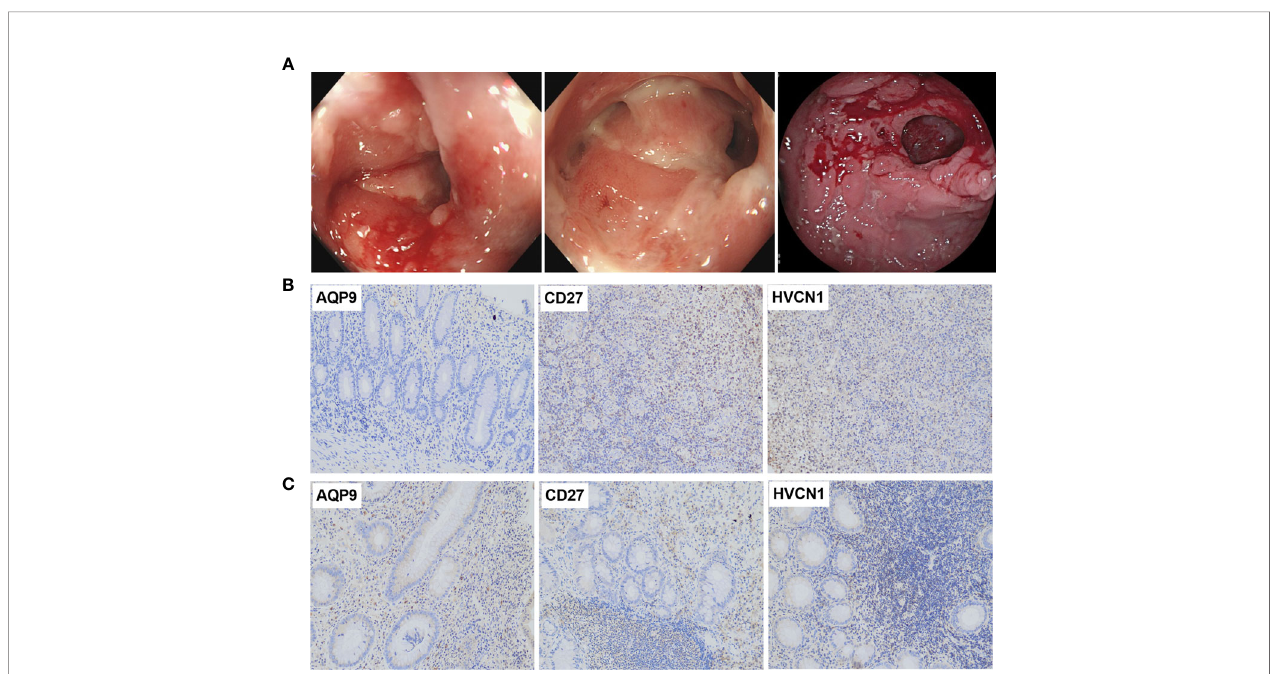
FIGURE 6 | (A) Typical endoscopic images of CD: left, ileum in remission; middle, ileocecal valve; right, colon with ulcer; (B) Expression of AQP9 , CD27 and HVCN1 in adjacent normal intestinal tissues, fewer immunostaining can be seen in the mucosa (Magni fi cation ×200); (C) Expression of AQP9 , CD27 and HVCN1 in CD tissues, more immunostaining can be seen in the mucosa (Magni fi cation